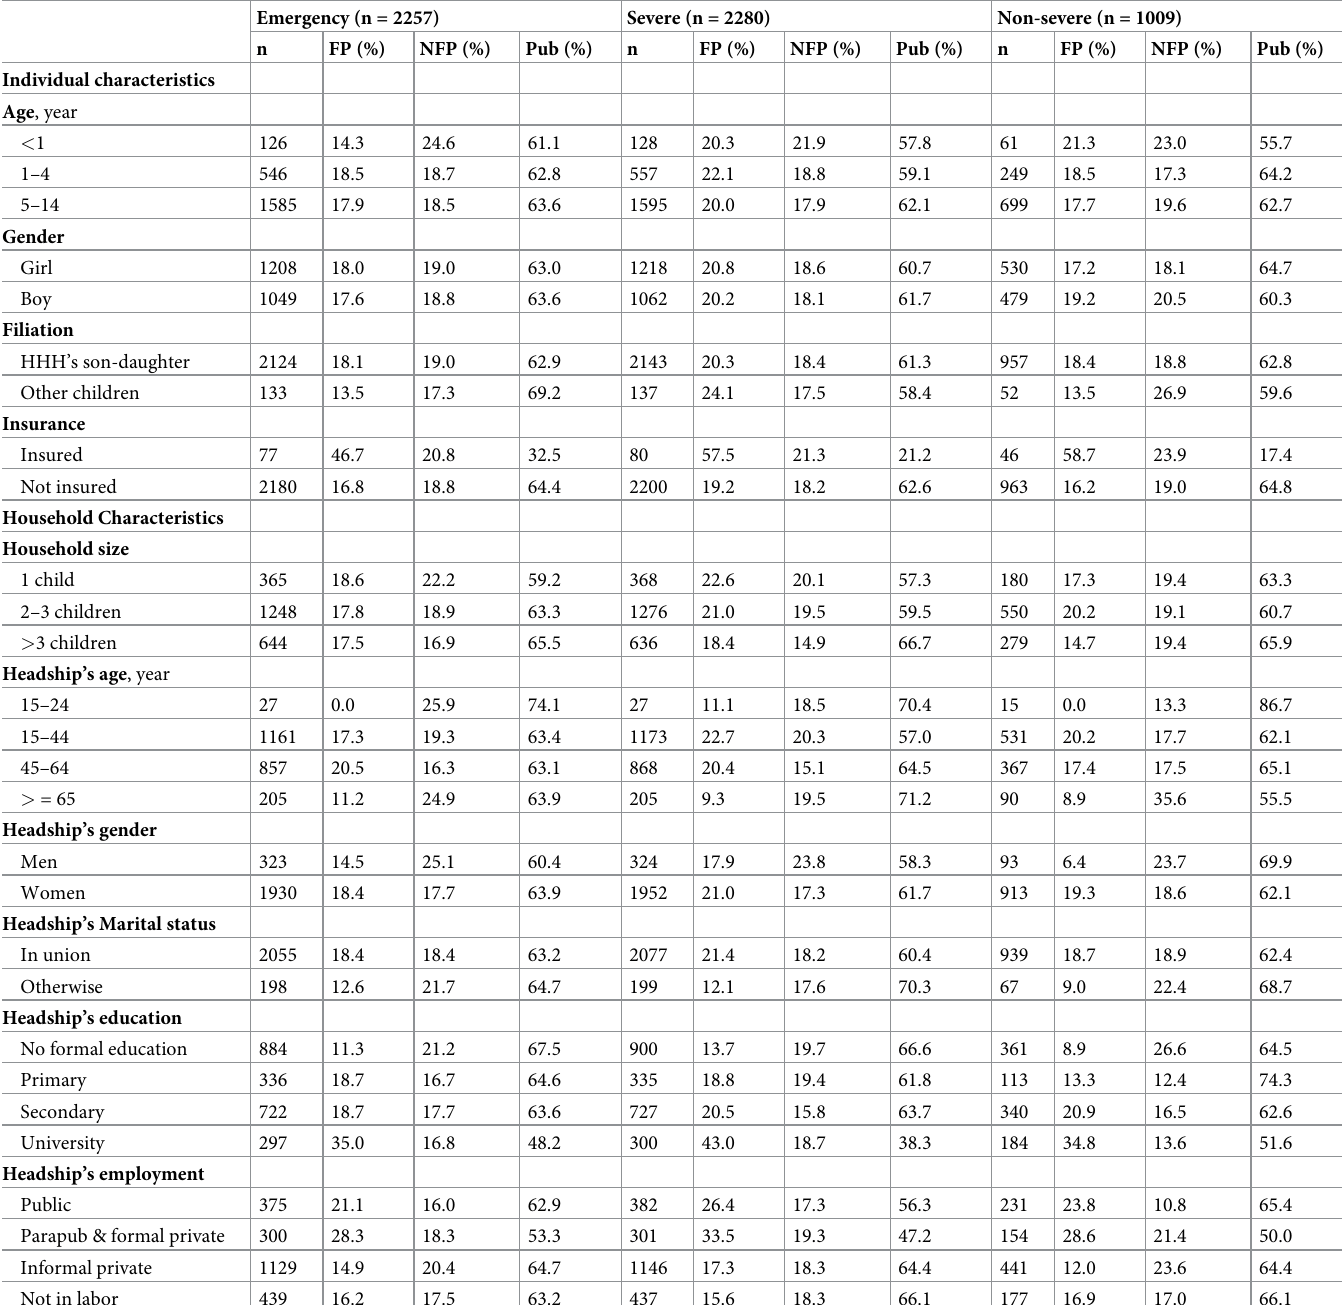
Table 3. Distribution of factors associated with the providers’ (FP, NFP & public) choice by health